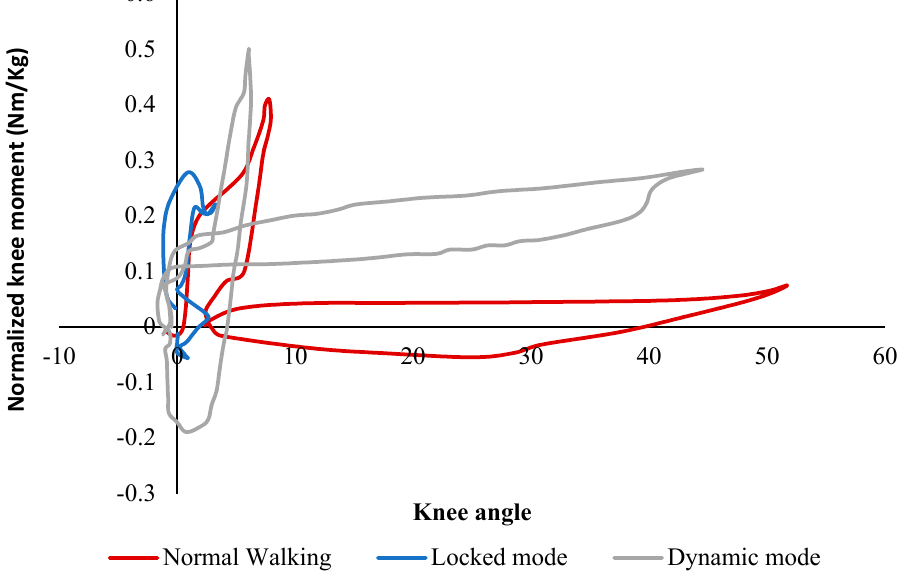
Figure 17. The Knee Stiffness Profiles (Weight-Normalized Knee Moment vs. Knee Angle) in the Slow Walking, the Locked Mode, and the Dynamic Mode [46].